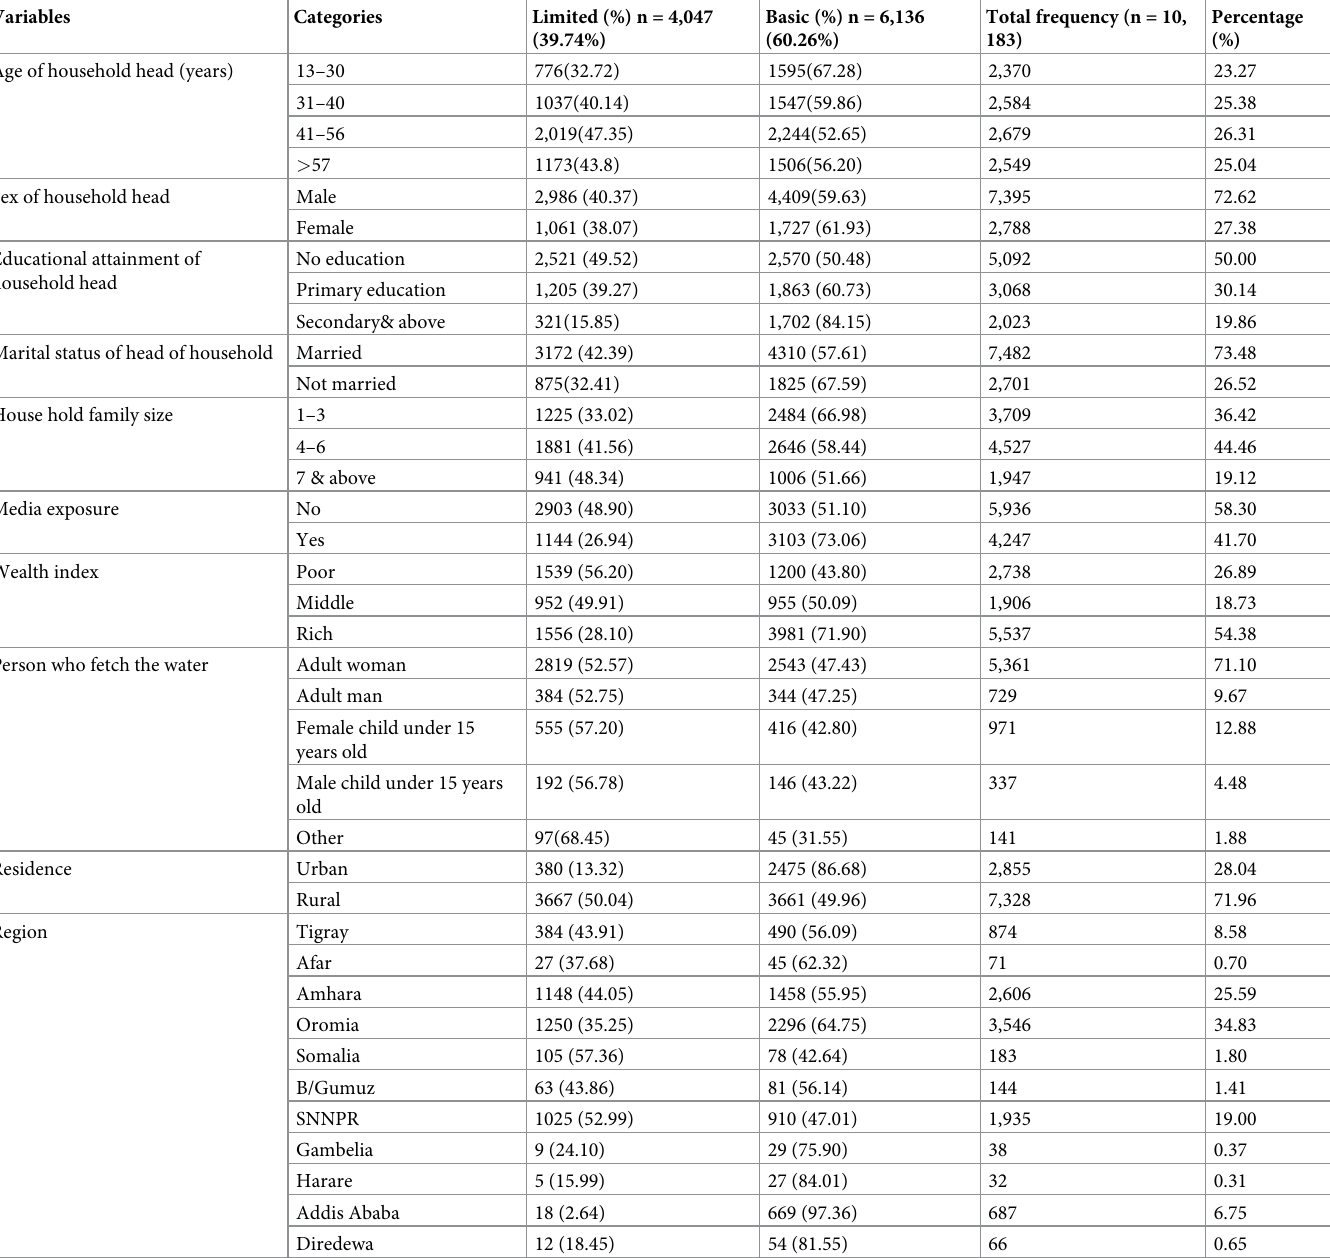
Table 1. Socio-demographic characteristics of the study population with limited access to an improved drinking water source in Ethiopia, 2016 EDHS.